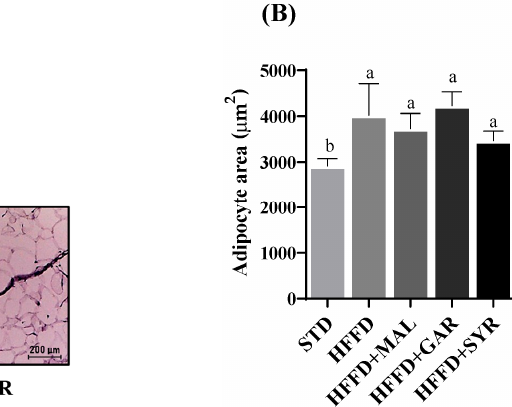
Figure 2. Mesenteric adipose tissue histology analysis and adipocyte area of rats fed a high-fat high- fructose diet supplemented with different varieties of grape pomace. ( A ) Representative histological images of adipose tissue. ( B ) Adipocyte area (µm 2 ). Values are reported as mean ± SD (n = 8). Different letters indicate significant ( p < 0.05) differences according to Tukey’s test. STD; standard